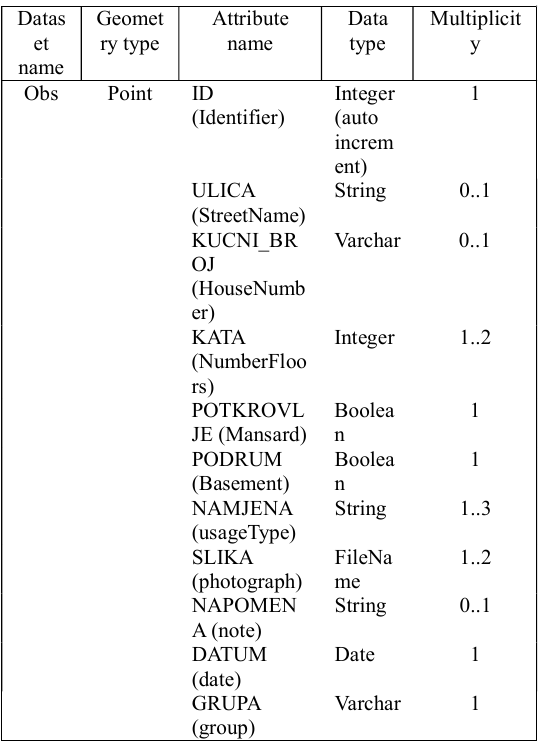
Table 1 Data model designed for field observations